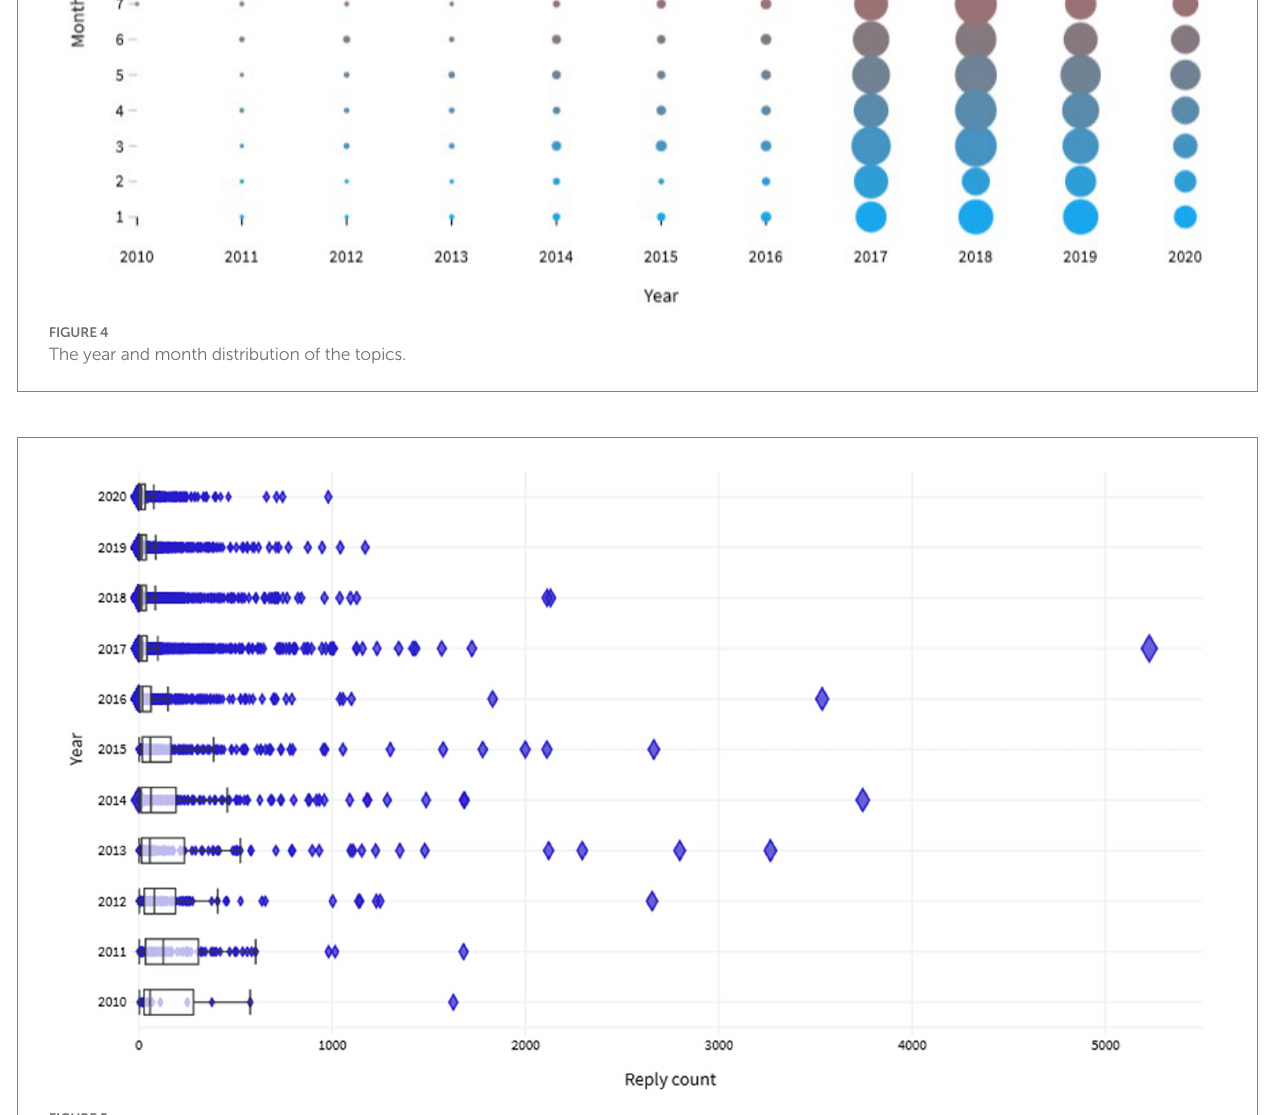
FIGURE 5 The distribution of the hot